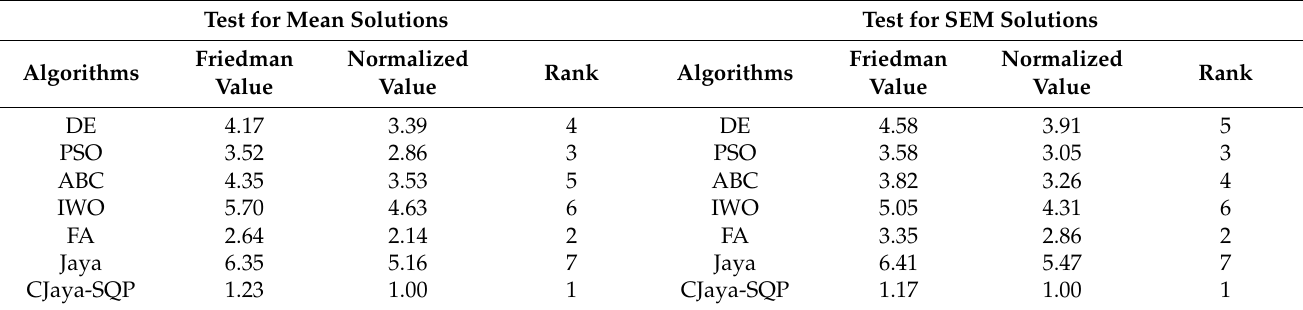
Table 10. Friedman rank test for the ‘Mean’ and ‘SEM’ solutions obtained for 100-dimensional functions over 30 runs.